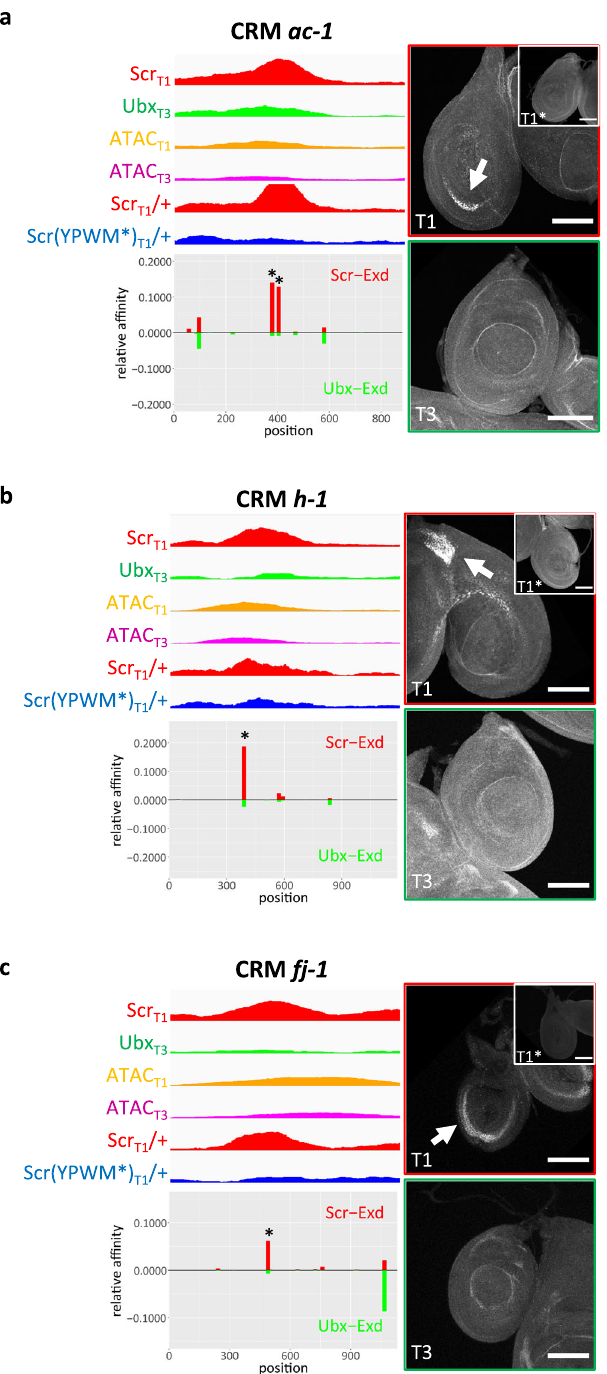
Fig. 6 Reporters generated from Exd-dependent Scr T1 > Ubx T3